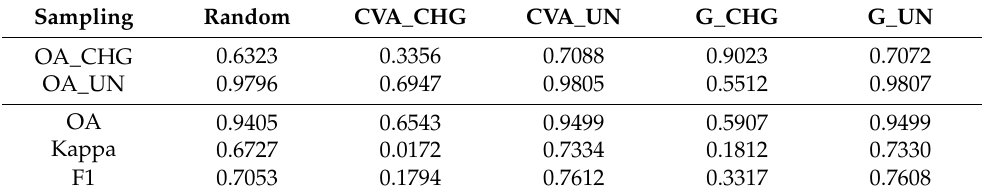
Table 5. Alteration detection results of dataset ‘River’ using different sampling strategies. Sampling